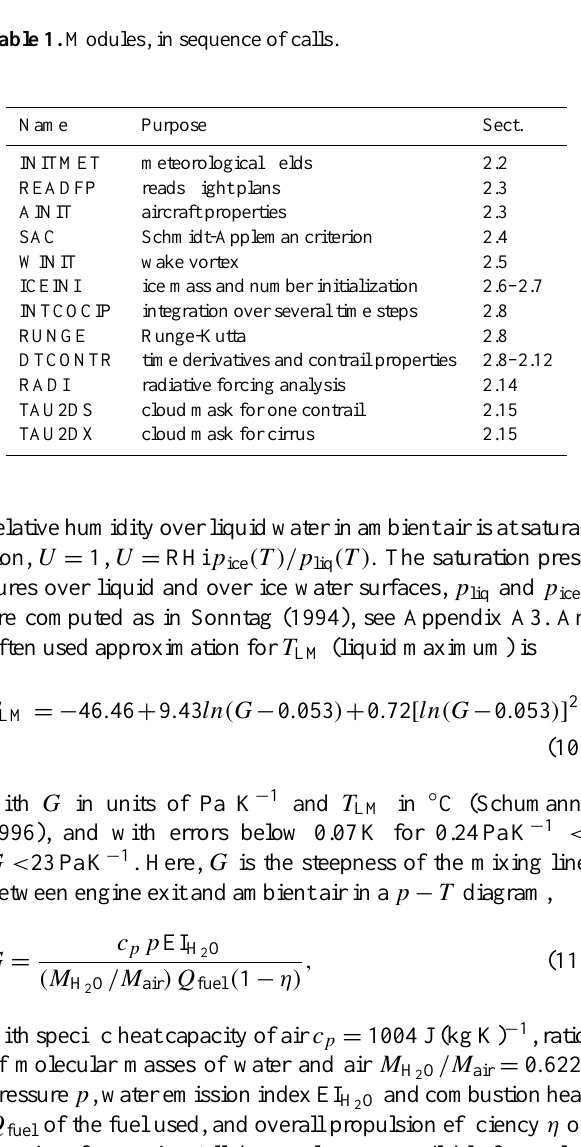
Table 1. Modules, in sequence of